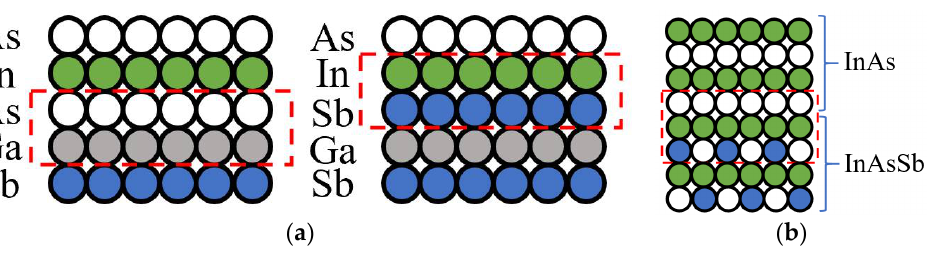
Figure 1. Interfaces in ( a ) InAs/GaSb SL and ( b ) InAs/InAsSb SL.